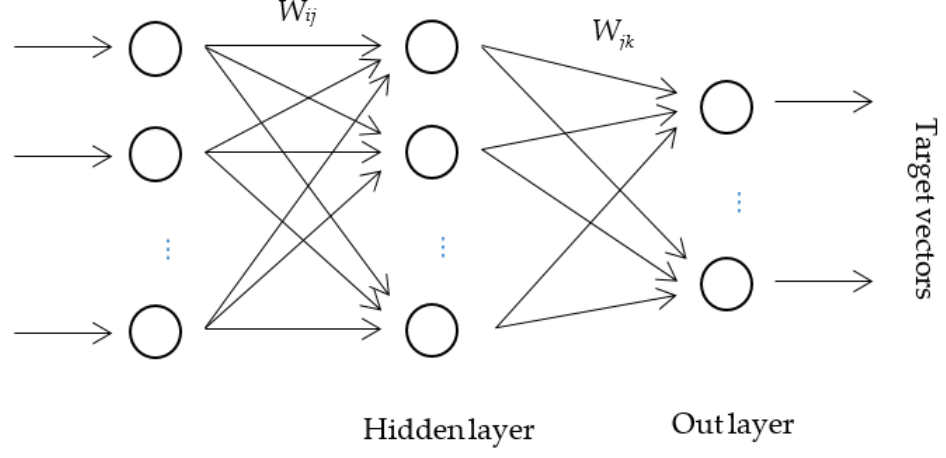
Figure 4. Three layers of the BP neural network.